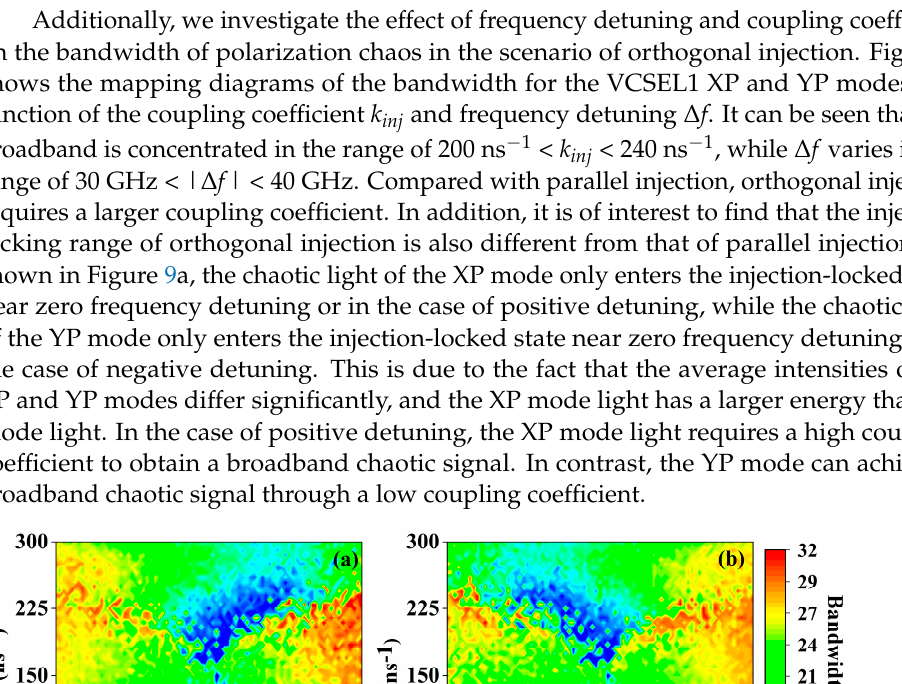
∆ f inj and frequency detuning